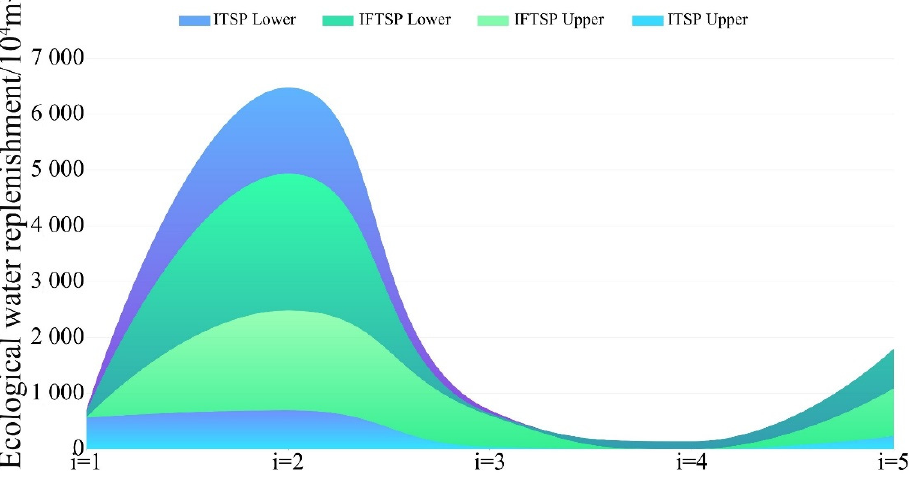
Figure 3. Comparison between IFTSP model and ITSP model optimisation schemes for the ecological water replenishment project of each lake in Boluo Lake National Nature Reserve. (i = 1 to 5 represent the Toudaogang Reservoir, Boluo Lake, Mobopao, Yuanbaowapao, and Aobaotupao, respec- tively). Table 2. Comparison between IFTSP model and ITSP model optimisation schemes for ecological water replenishment of each lake bubble in Boluo Lake National Nature Reserve. Name of Lake Bubble